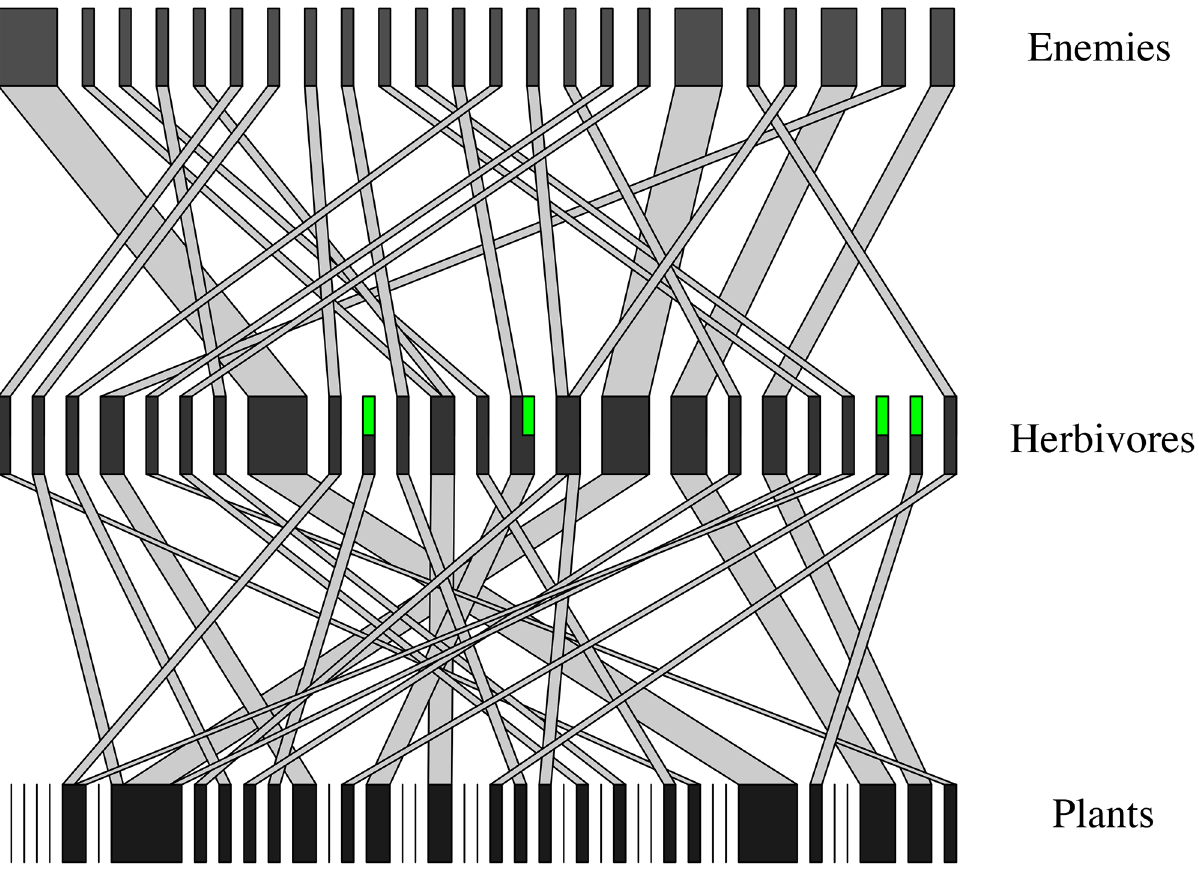
Fig 1. A randomly selected tri-tropic network produced from one of the 1000 simulations. Each black bar is a node representing a unique species, while the grey bars are edges connecting the black bars and represent observed interactions between those two species. Green sections within some of the black bars represent individuals within that particular species that were present in the community, but not involved in trophic interactions (e.g., plants without herbivores). The width of each edge and node within the network denotes the abundance of sampled interactions or species. Only species that were sampled are shown in this network. Numbers above each node denote the species identification number from that particular simulation.